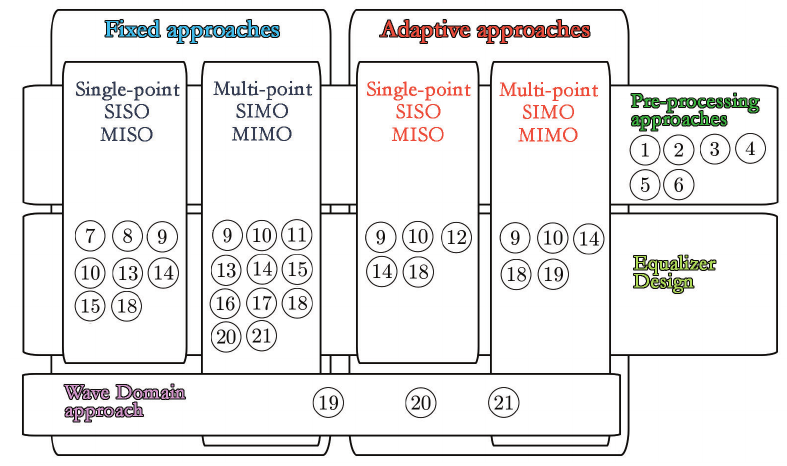
Figure 1. A general classification of room response equalization (RRE) systems. Possible approaches: 1 short filters, 2 complex smoothing, 3 frequency warping, 4 Kautz filters, 5 multirate approaches, 6 room impulse response (RIR) reshaping, 7 homomorphic filtering, 8 linear predictive coding analysis, 9 least-squares optimization techniques, 10 frequency domain deconvolution, 11 multiple-input/multiple-output inverse theorem (MINT) solutions, 12 average and weighted average methods, 13 clustering methods, 14 prototype approach, 15 common acoustical poles compensation, 16 modal equalization, 17 plane wave approach, 18 quasi-anechoic approach, 19 wave domain adaptive filtering, 20 transform domain approaches, 21 room geometry aware methods. MIMO: multiple-input/multiple-output; MISO: multiple-input/single-output; SIMO: single-input/multiple-output; SISO: